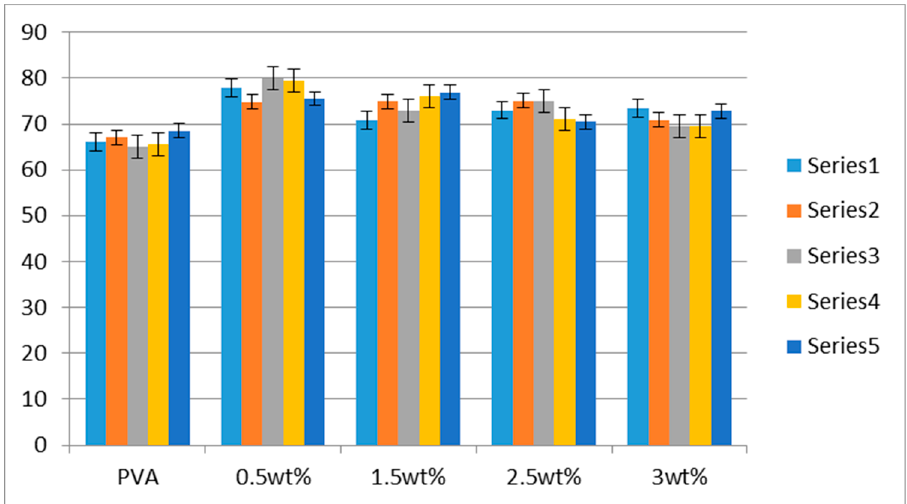
Figure 6. XRD spectra of pure PVA, 0.5%, 1.5%, 2.5%, and 3% AV / PVA electrospun nanofibers.